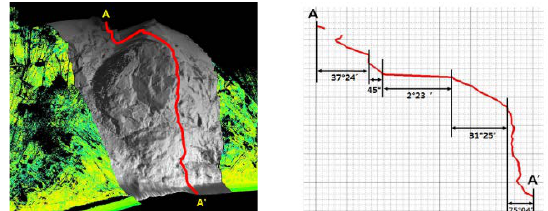
Figure 6. Pyeongchang-gun steep slope collapsing danger zone